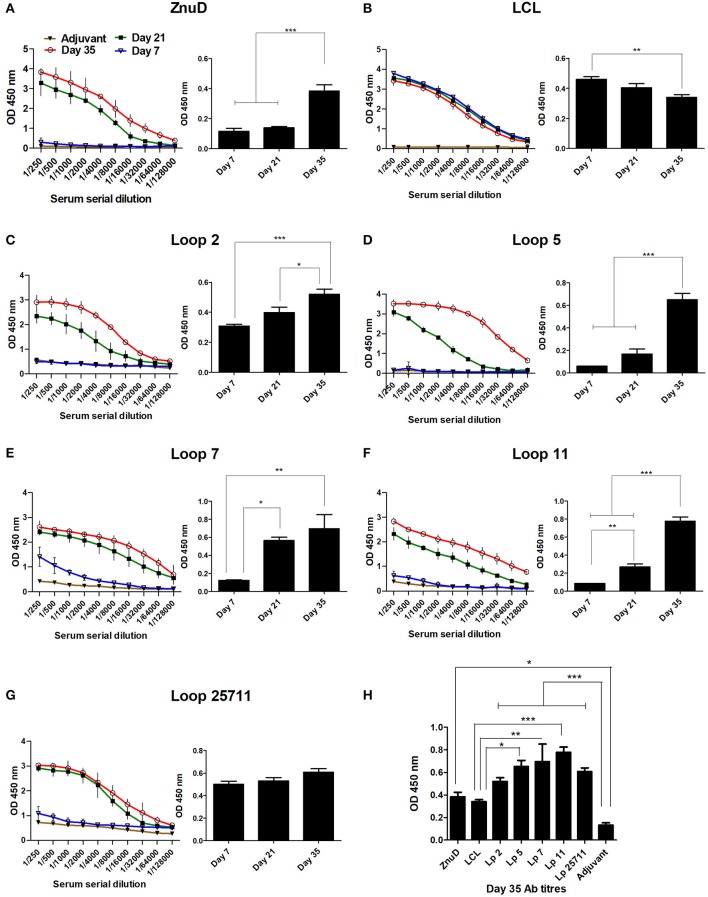
Serum collected from the immunized mice were analyzed for IgG titres against the immunizing protein. (A–G) Display the absorbance values (OD 450) at two-fold serial dilutions of the serum and the absorbance value at the highest dilution tested (1/128,000) at days 7, 21, and 35. (H) The absorbance value for all sera tested at the dilution 1/128,000 at day 35. Sera from mice from each immunization group (n = 6) were assayed in duplicate at each time-point. The adjuvant control group (n = 6) were assayed at the last time-point. Significance is displayed as *p < 0.05, **p ≤ 0.01, and ***p < 0.001.